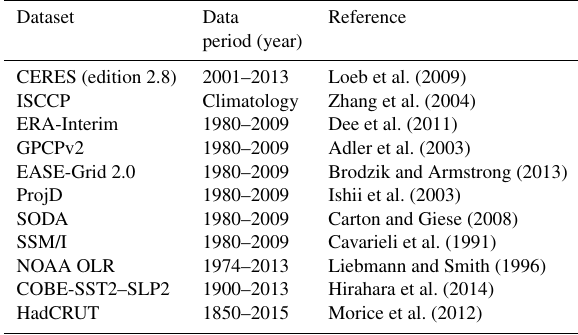
Table 1. Summary of observation and reanalysis datasets used as references in the present